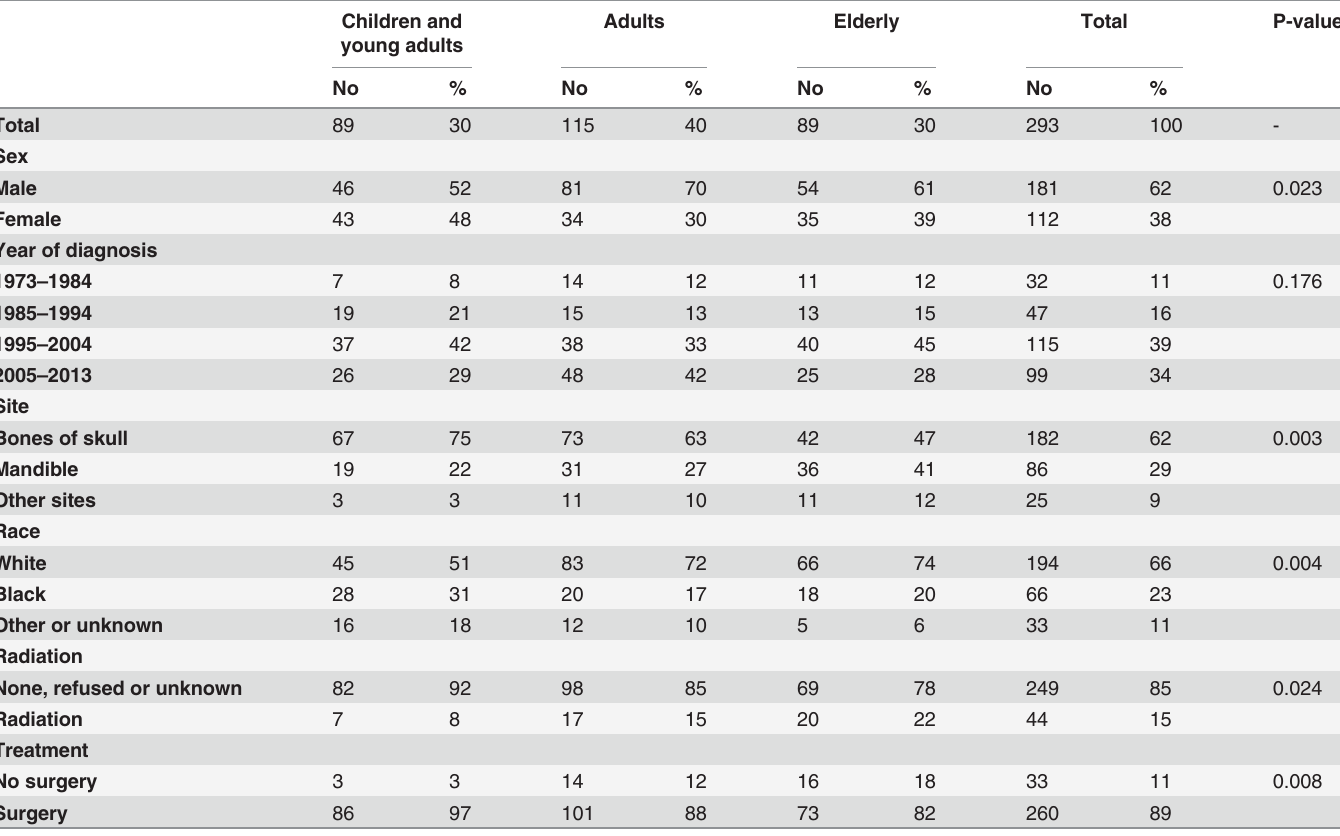
Table 1. Baseline characteristics of patients.